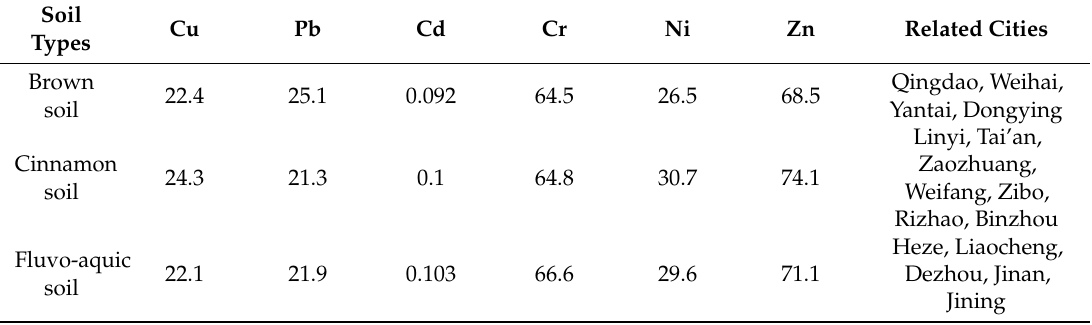
Table 1. The background values of the metals in di ff erent cities of Shandong Province (mg · kg − 1